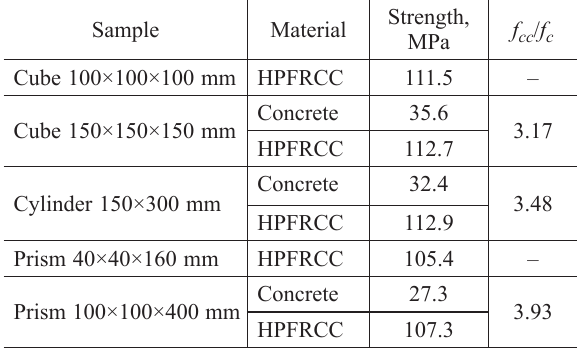
Table 3. Strength of compressed samples Sample